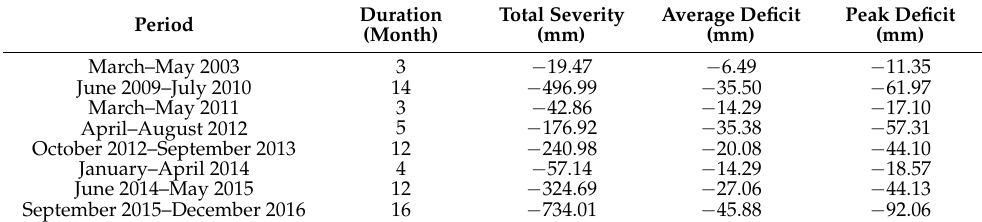
Table 3. A summary of the detected drought events based on the downscaled